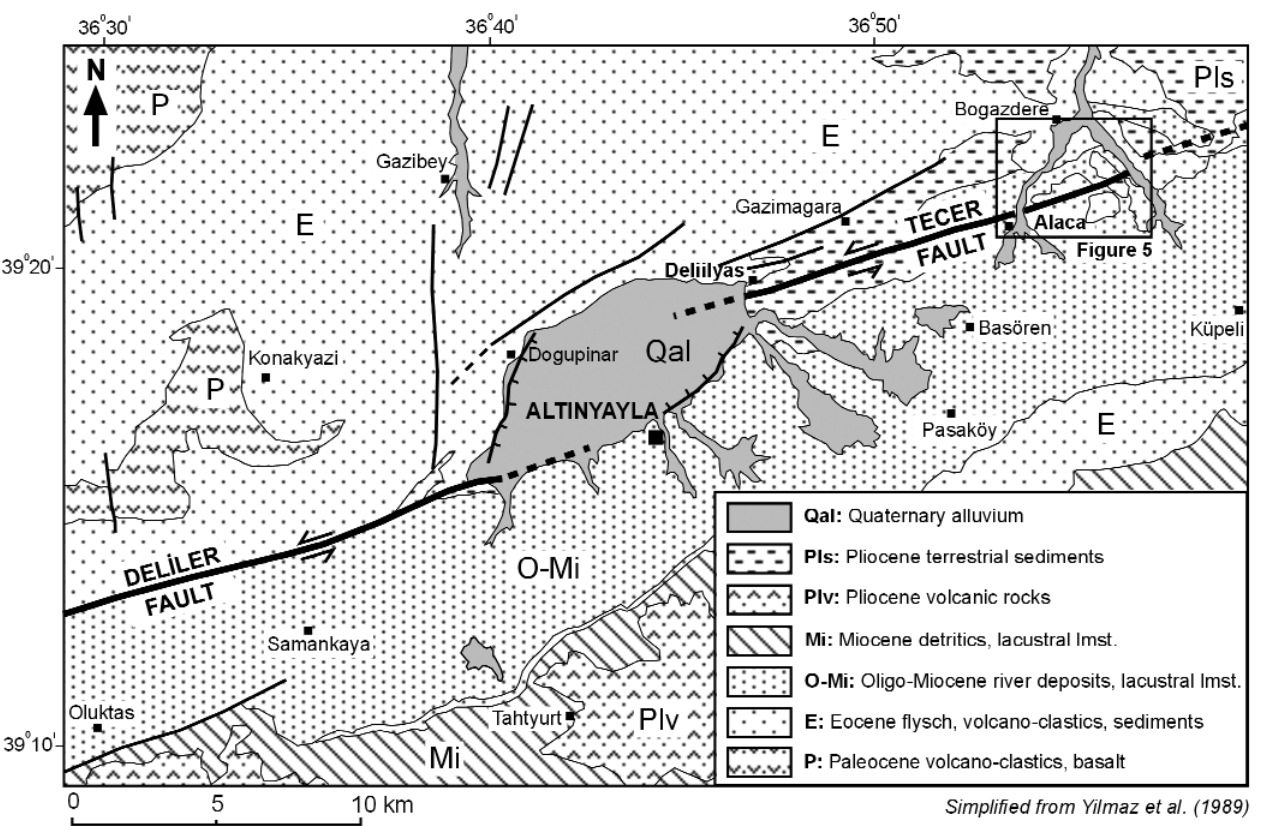
Figure 1. Main active tectonic elements for Turkey [modified from Saroglu et al. 1992], with Tecer Fault (TF) taken from Aktimur et al. [1990] and added to this study. For abbreviations, see key.